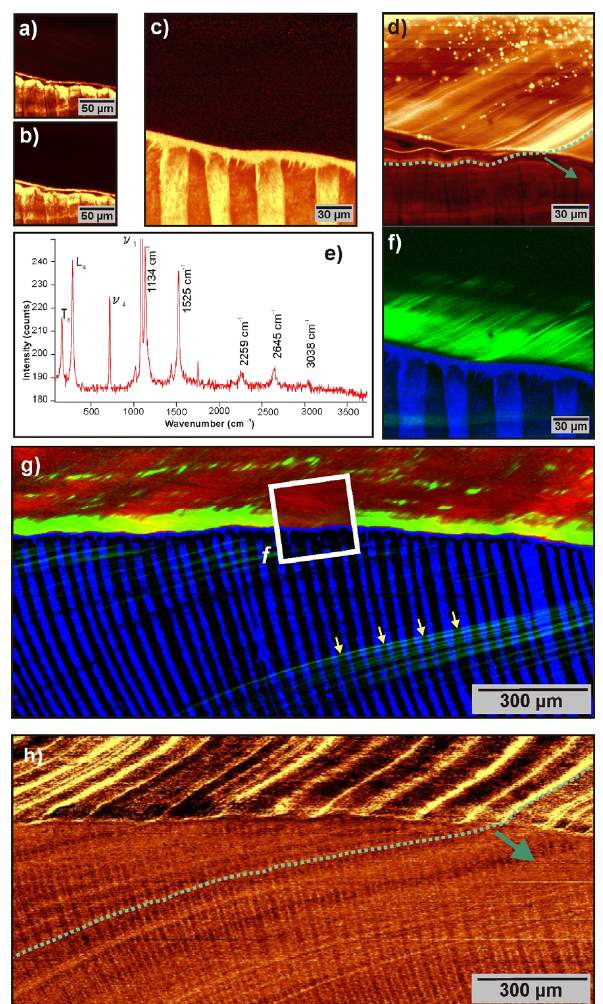
Fig. 3. (a) Map showing the intensity distribution (peak area) of the lattice peak of aragonite (translation mode T a at 152cm − 1 ) ex- tracted from scan2a. (b) Map showing the intensity distribution of the lattice peak (peak area) of aragonite (librational mode L a , 206cm − 1 ) . (c) Map calculated from the ratio of map 3a and 3b. (d) Map showing the intensity distribution of the background in- tensity (between 2400cm − 1 and 2500cm − 1 ) related to the fluores- cence of the sample. Dotted-line marks one growth layer and arrow marks the direction of growth. (e) Raman spectra extracted from scan2a showing the typical aragonite spectra and the RR peaks re- lated to the presence of polyenes. (f) Map calculated from scan2a showing the distribution of the polyenes (green) (g) Map show- ing the distribution of calcite (red), aragonite a (black), aragonite b (blue), and polyenes (green) as extracted from scan2b. The area f in- dicates the area in, which the previous scan (scan2a) was performed. The arrows in the aragonitic domain highlight where polyenes visu- alize the growth lines of the shell. (h) Map showing the change in F ull W idth H alf M aximum (FWHM) of the symmetric stretch ν 1 of carbonate group at 1085cm − 1 extracted from scan2b. Dotted-line marks one growth layer and arrow marks the direction of